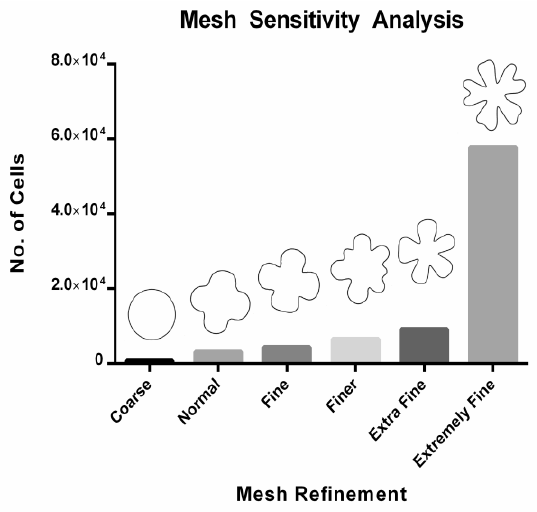
Figure 2. Mesh sensitivity analysis for comparison of a numerical model in experiment by Chen et al. [51] .